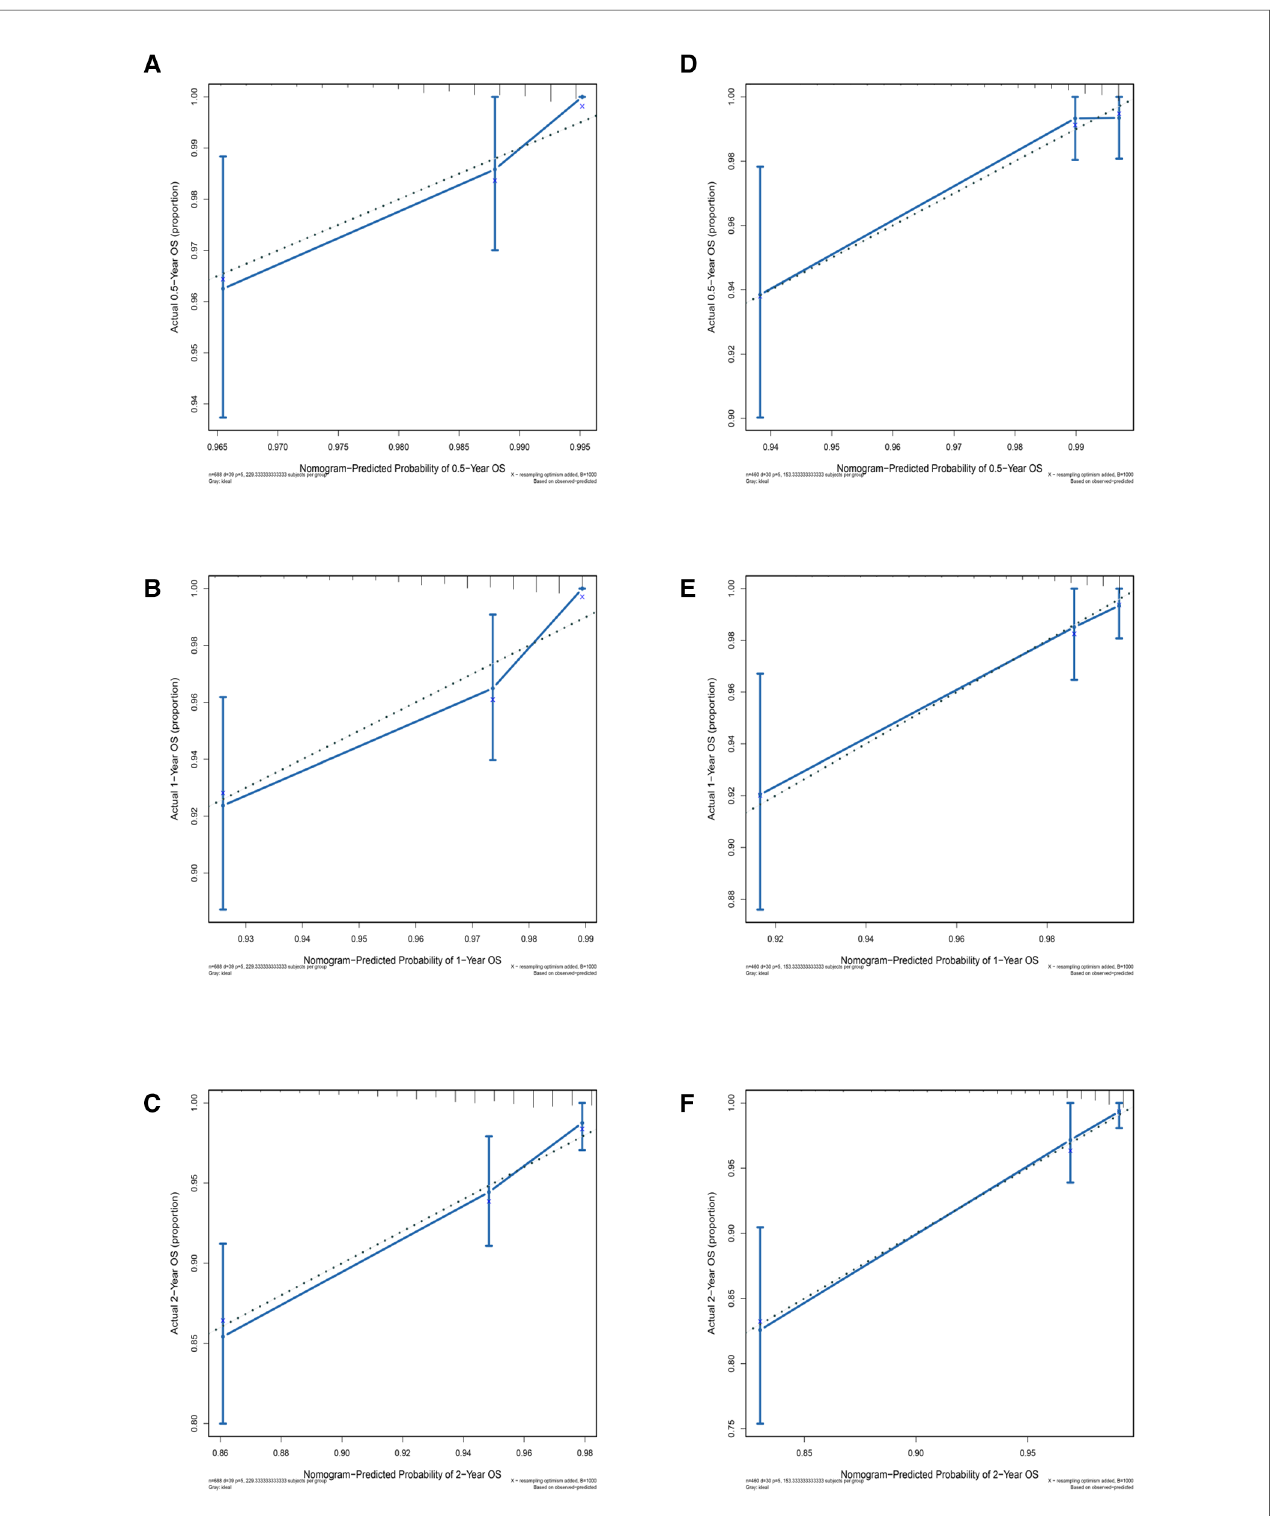
FIGURE 3 Calibration curves for different years of training and testing prognostic nomograms. Calibration curve for the training group at six months, one year, and two years. ( D – F ) Calibration curve for the testing group at six months, one year, and two